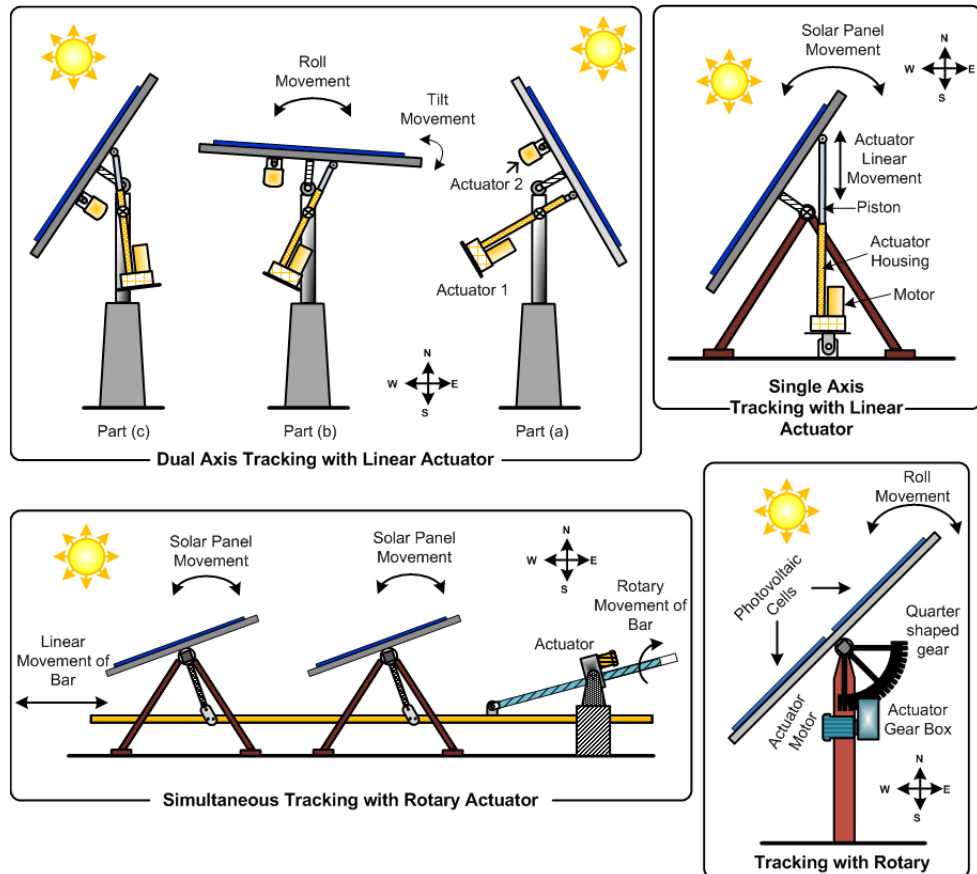
Figure 2. Electric actuators functioning in solar tracking